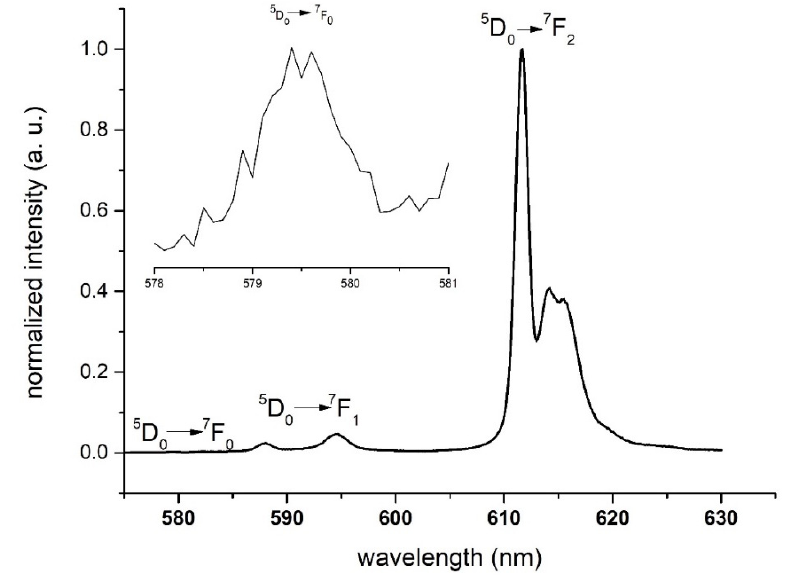
Figure 1. Normalized emission spectra of 1 (black line) relative to the most intense 5 D 0 → 7 F 2 transition band at 25 °C in the solid state with λ exc. = 345 nm. Inset magnification of 5 D 0 → 7 F 0 transition band (wavelengh range 578–581 nm).